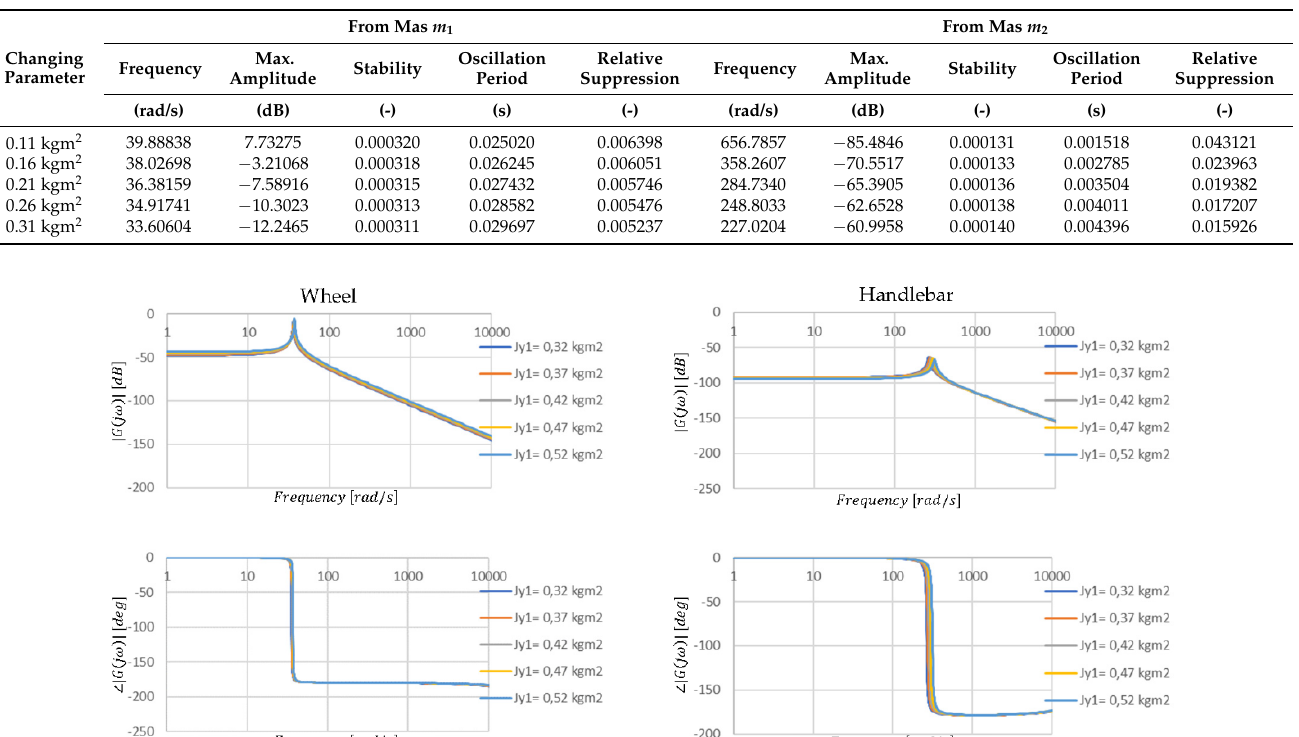
Figure 8. Amplitude and phase characteristics of the steering angle position transmittance when the parameter values are changed J x 1 and J z 1 . Table 2. The values of the parameters read from the graphs shown in Figure 8.